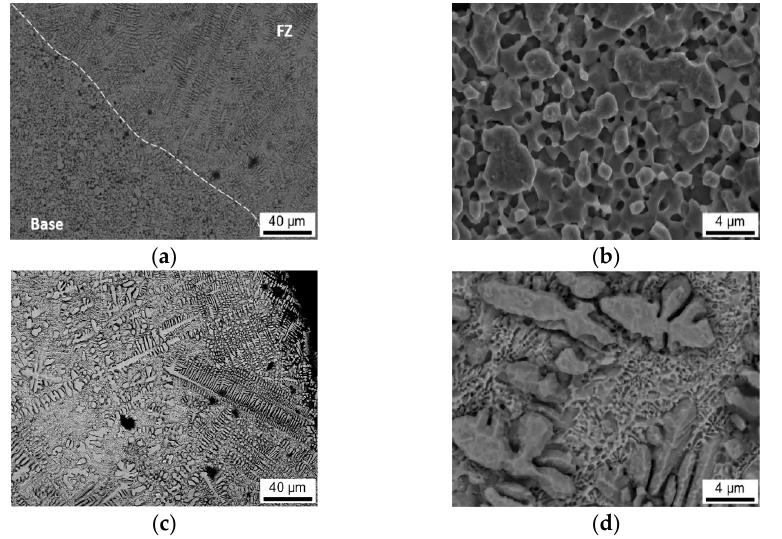
Figure 8. The surface microstructure of the Mo-Si-B alloy with electron beam remelting. ( a ) melt pool and substrate transition area; ( b ) substrate area; ( c ) specimen surface morphology; ( d ) interdendritic area of the melt pool.